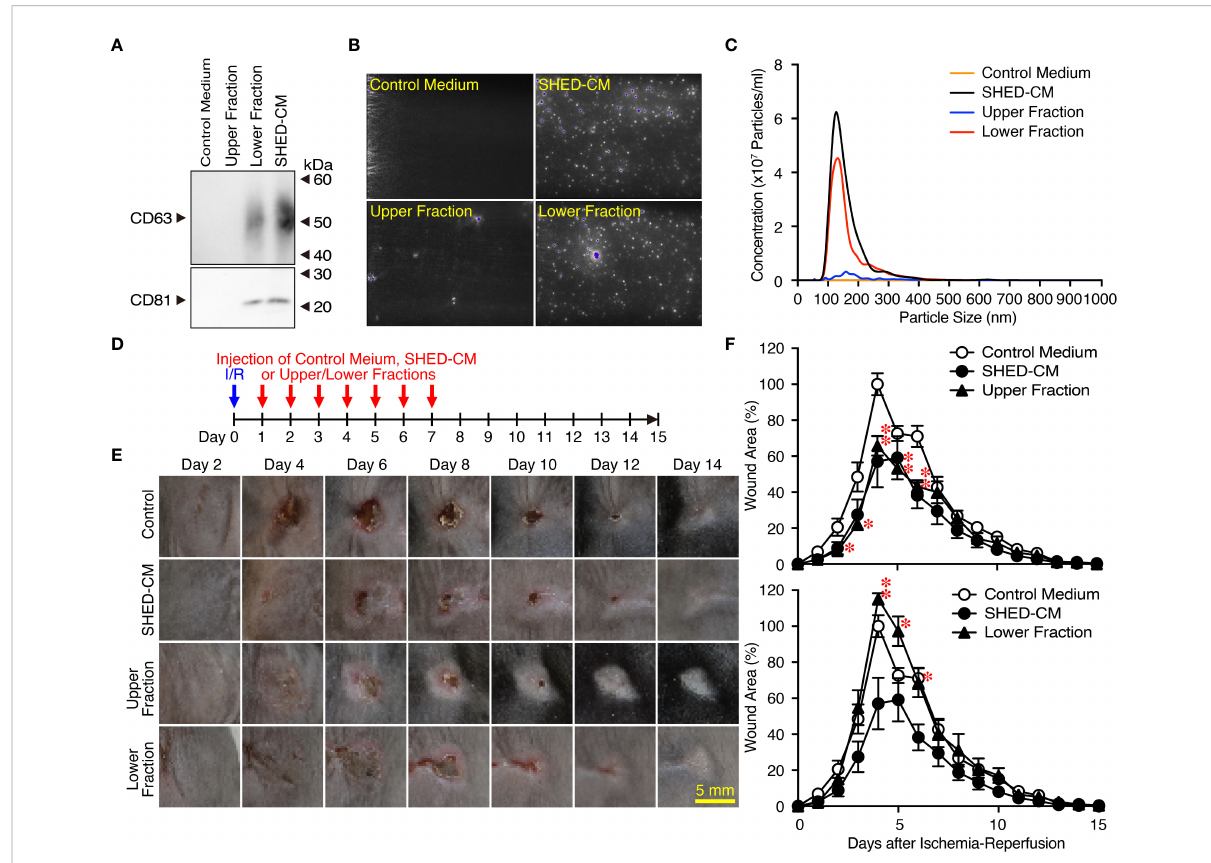
FIGURE 3 Exosomes in the SHED-CM have little inhibitory effects on PU formation. (A – C) SHED-CM was separated into two fractions by ultracentrifugation: the upper fraction contained SHED-CM without exosomes and the lower fraction contained precipitated exosomes from SHED-CM. The precipitate was resuspended in the same volume of control medium before ultracentrifugation. The content of exosomes was analyzed with western blotting using antibodies against CD63 and CD81 following SDS-PAGE (A) , and scanning electron microscopy analysis (B) and nanoparticle tracking analysis (C) with NanoSight. (D) After cutaneous I/R injury was induced on the dorsal skin of mice in a mouse model for PU formation using two magnetic plates, 100 µl SHED-CM, control medium, SHED-CM depleted of exosomes, and only exosomes derived from SHED-CM were injected into the dermis at two sites around the wound at the indicated time points. (E) Representative photographs of the ulcers are shown. (F) The size of the wound areas in each photograph was evaluated using FIJI, and relative wound areas at each time point to the maximum area in control mice on day 4 as 100% were calculated. Data are shown as the mean ± SEM (n = 5) and are representative of three (A) , three (E, F) or four (B, C) independent experiments. P values were determined by the unpaired two-tailed Student t-test. * P < 0.05, ** P <